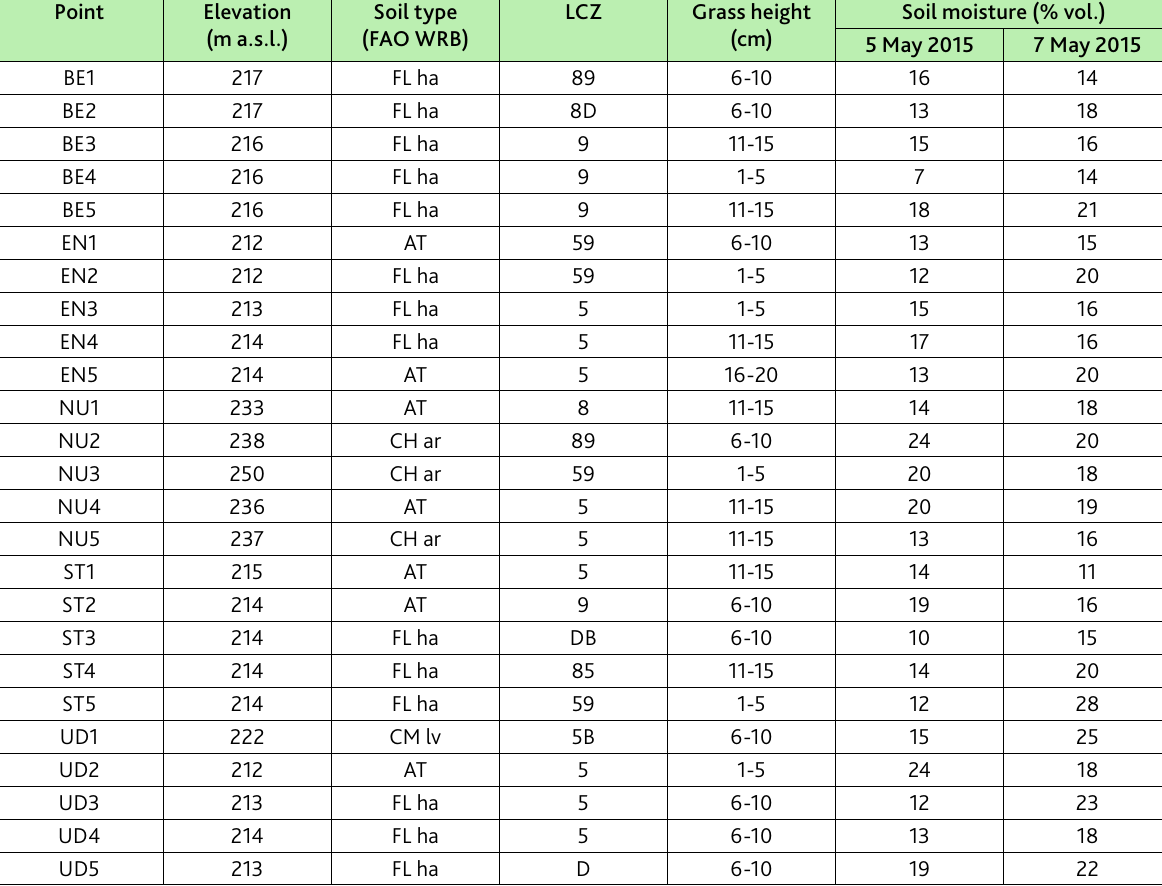
Table 1. Characteristics of the research points of the field experiment* Point Elevation Soil type LCZ Grass height Soil moisture (% vol.) (m a.s.l.) (FAO WRB) (cm)